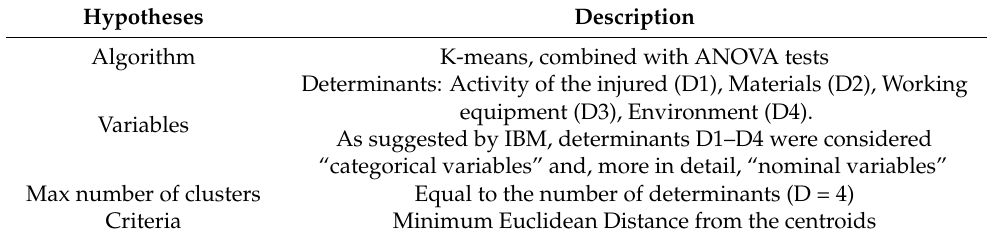
Table 5. Cluster analysis